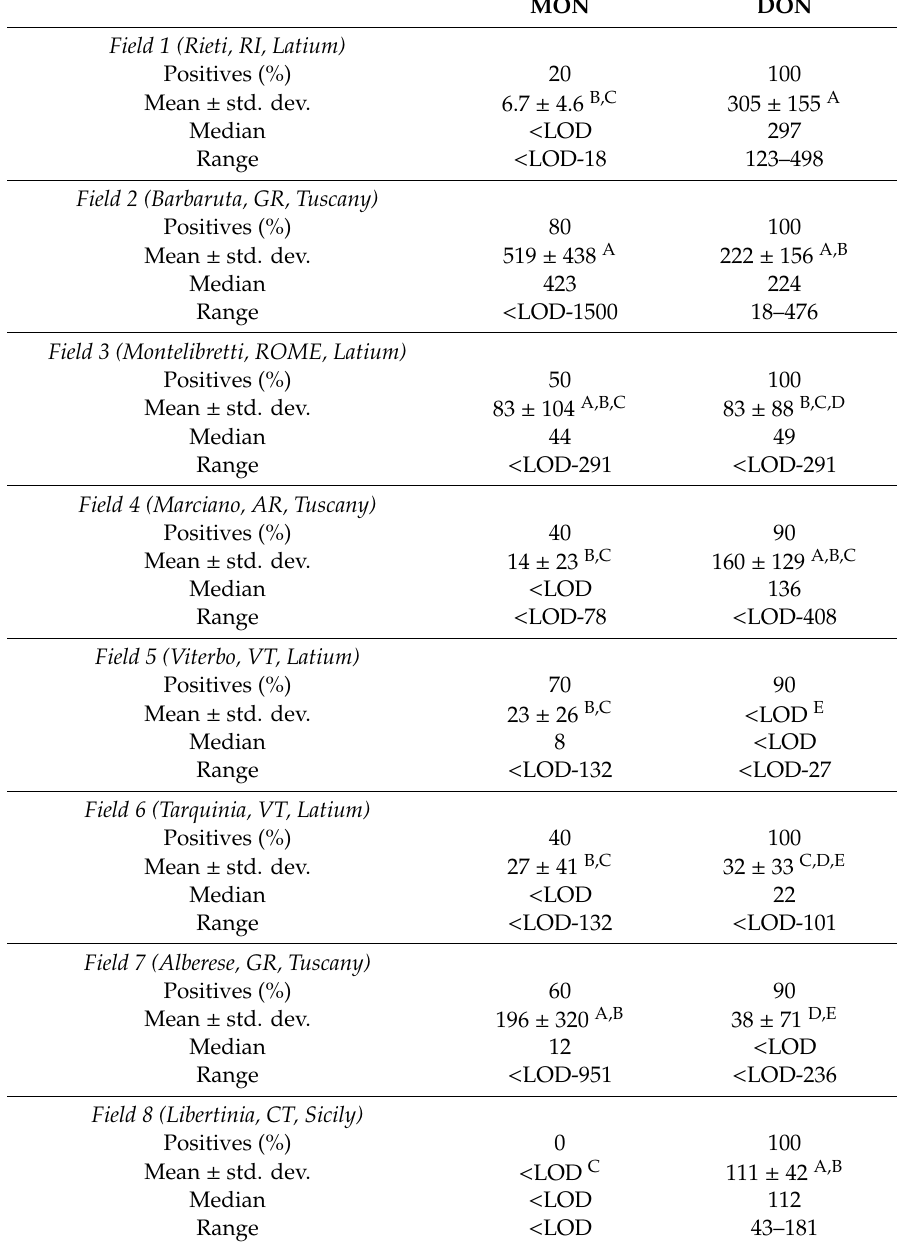
Table 2. Descriptive statistics of moniliformin (MON) and deoxynivalenol (DON) contamination ( µ g kg − 1 ) for durum wheat samples collected in Italy in